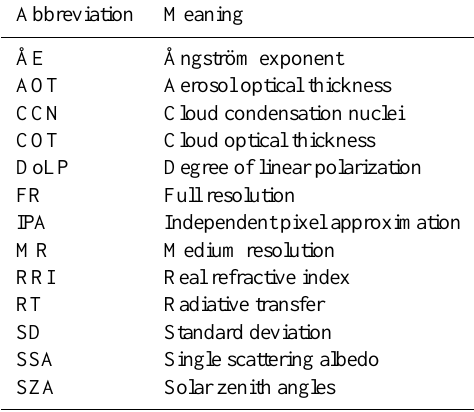
Table A1. Summary of